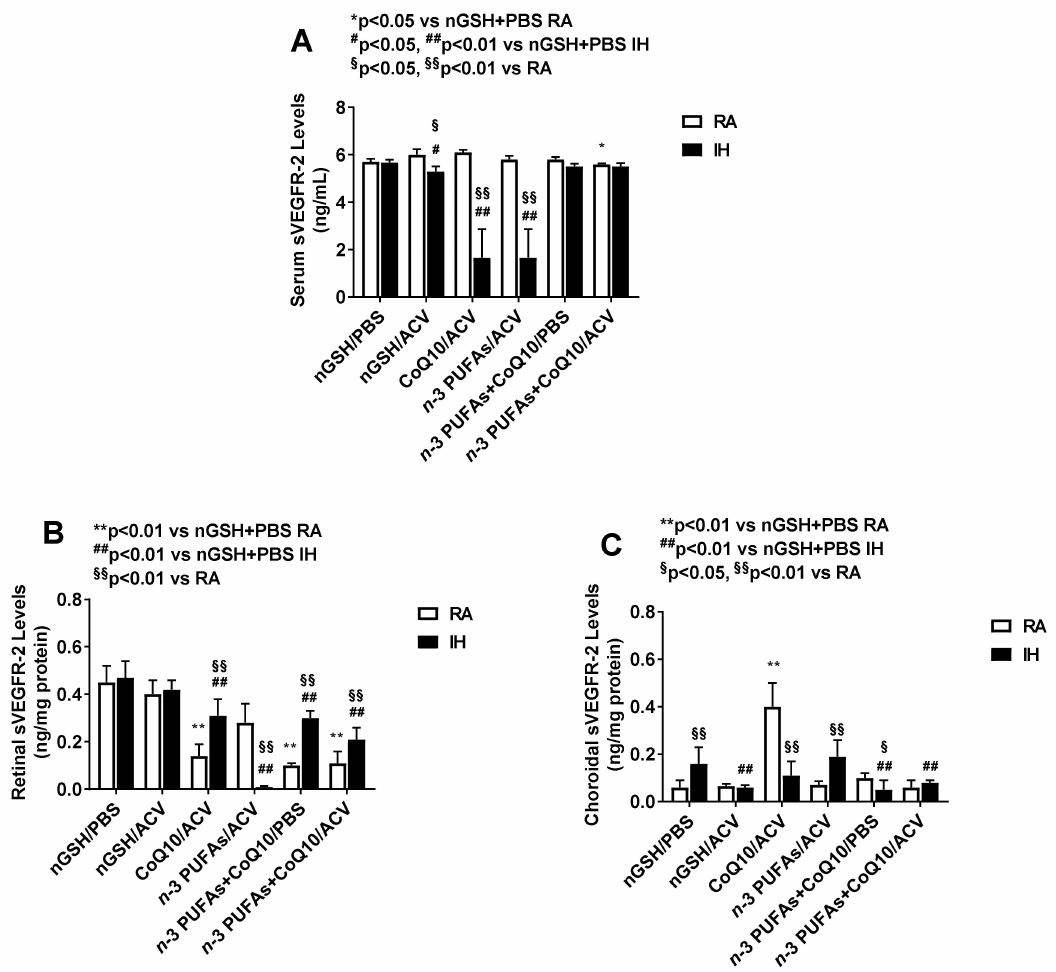
Figure 4. E ff ects of combination treatments on soluble vascular endothelial growth factor receptor (sVEGFR)-2 levels in the serum ( A ), retina ( B ), and choroid ( C ). sVEGFR-2 was not detected in the vitreous fluid. Levels in the retinal and choroidal homogenates were standardized using total cellular protein levels. The open bar represents the room air (RA) groups and the solid bar represents the IH groups. Data are expressed as mean ± SD ( n = 6 samples / group for serum; and n = 4 samples / group for vitreous fluid, retina and